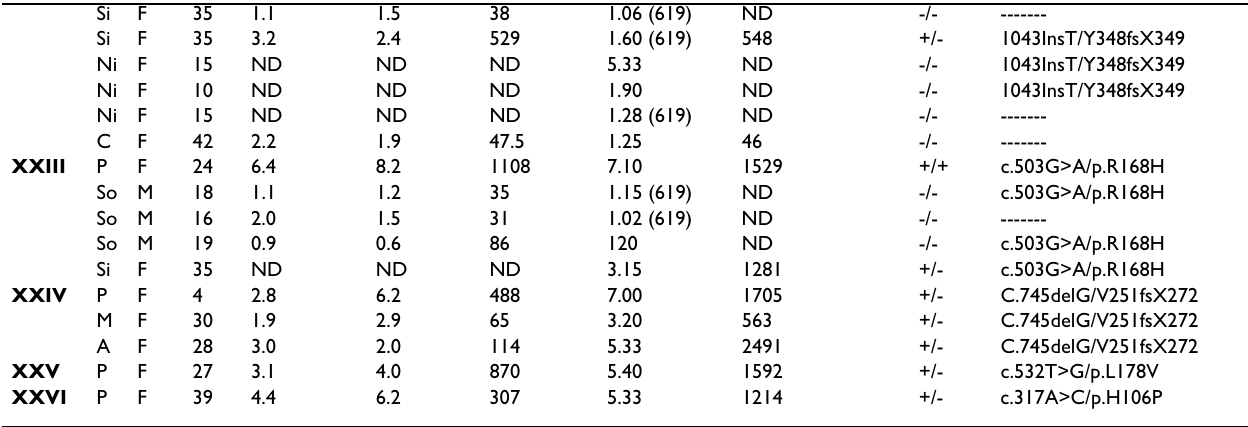
Table 1: VP Argentinean families: biochemical and molecular data